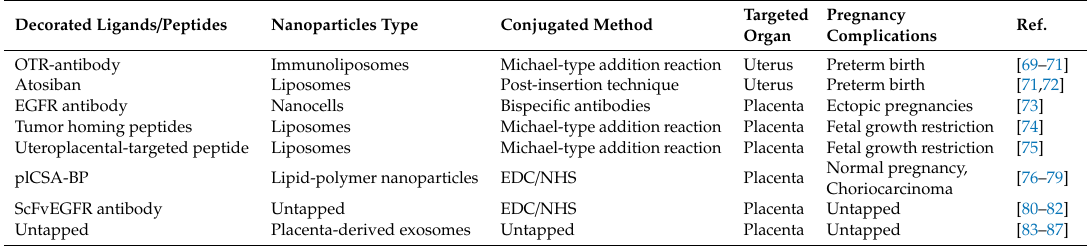
Table 1. Surface-functionalized nanoparticles as tools in targeted therapy of pregnancy complications. Decorated Ligands /